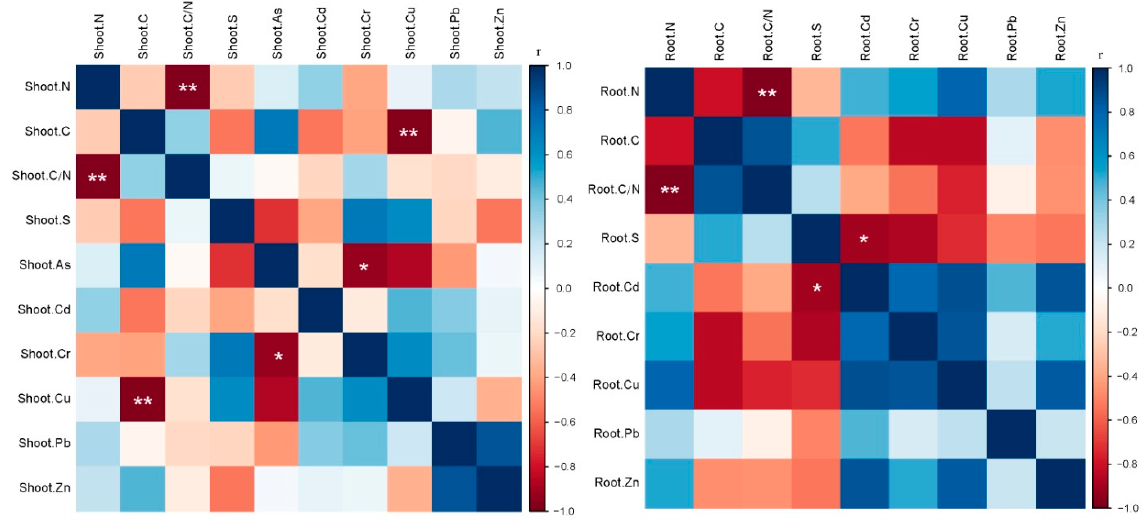
Figure 3. The Pearson correlations among shoot and root chemical properties and their heavy metal contents of B. ischaemum . Shoot and root chemical properties include total nitrogen (N), total carbon (C), total sulphur (S), and ration of carbon and nitrogen (C/N). ** Correlation is signi fi cant at the 0.01 level (2-tailed), * Correlation is signi fi cant at the 0.05 level (2-tailed).